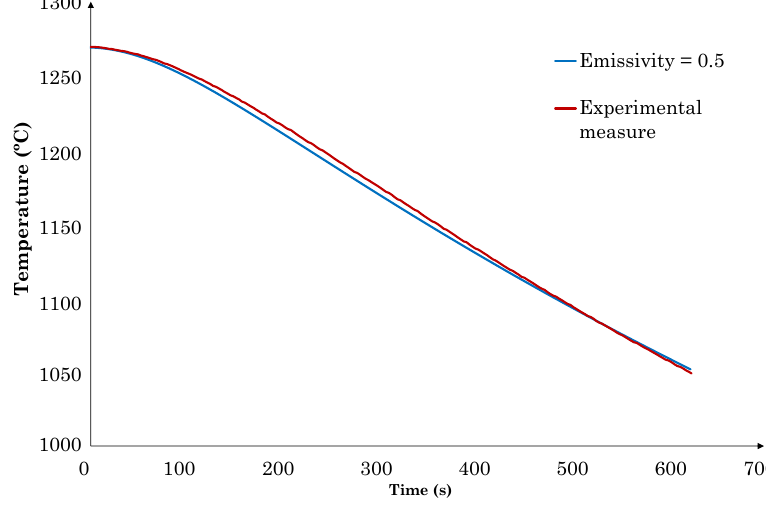
Figure 8. Fitting of the emissivity of the surface of the